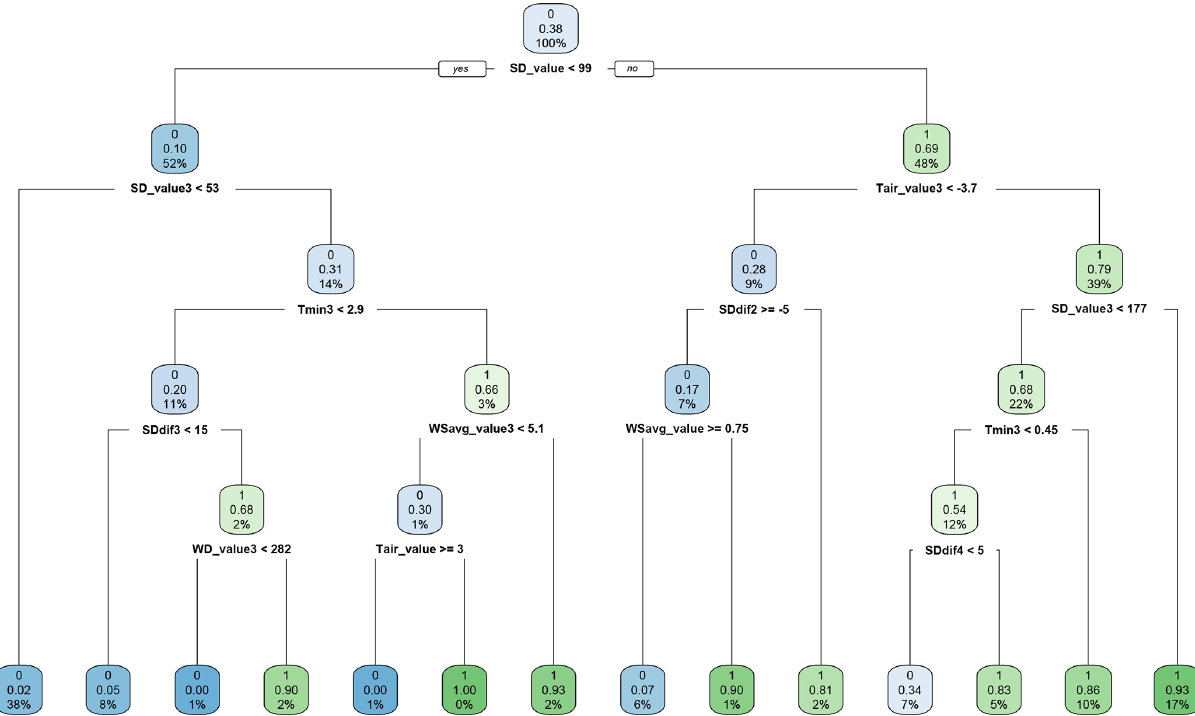
Figure 5. The decision tree of weather variables triggering wet avalanches. Numbers 1 and 0 denote avalanche day and non-avalanche day. The single value means the probability of occurrence/non-occurrence of avalanche release. The percentage signifies what percent of data are influenced by the split node from the wet SMOTE avalanche dataset.